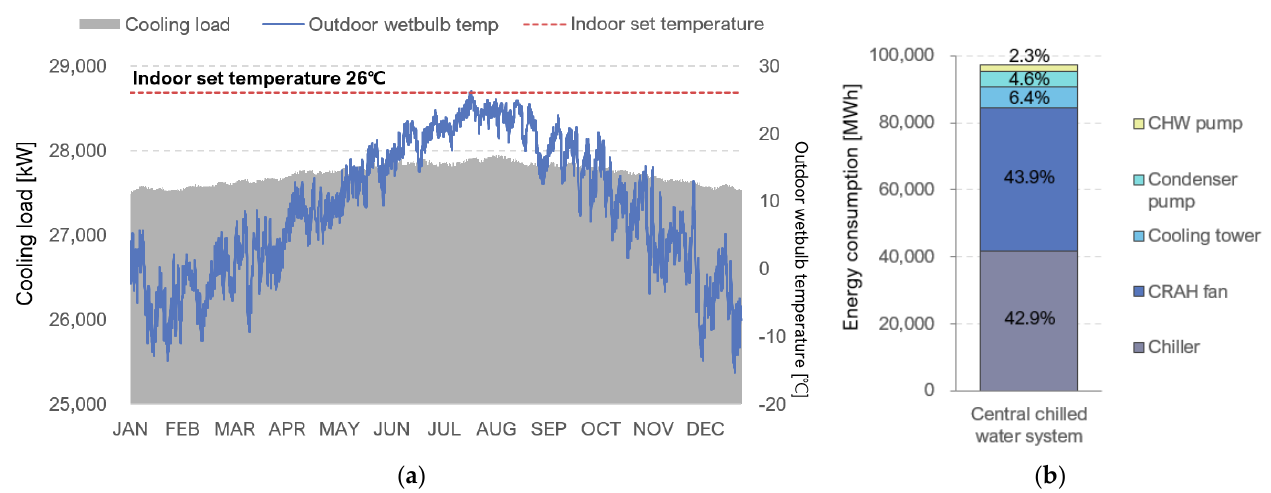
Figure 4. Annual internal load and type 1 energy consumption of the computer room. ( a ) Internal load of computer room, ( b ) type 1 energy consumption.